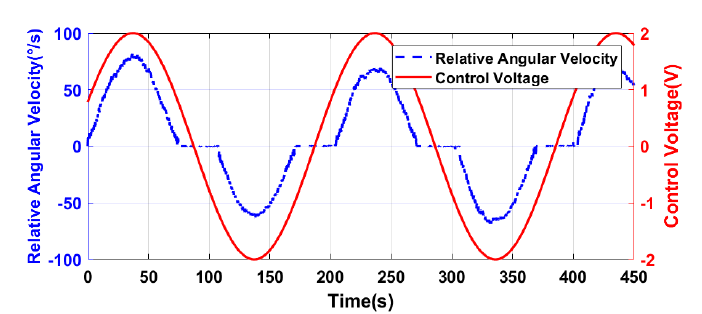
Figure 6. Control voltage and response in the open-loop